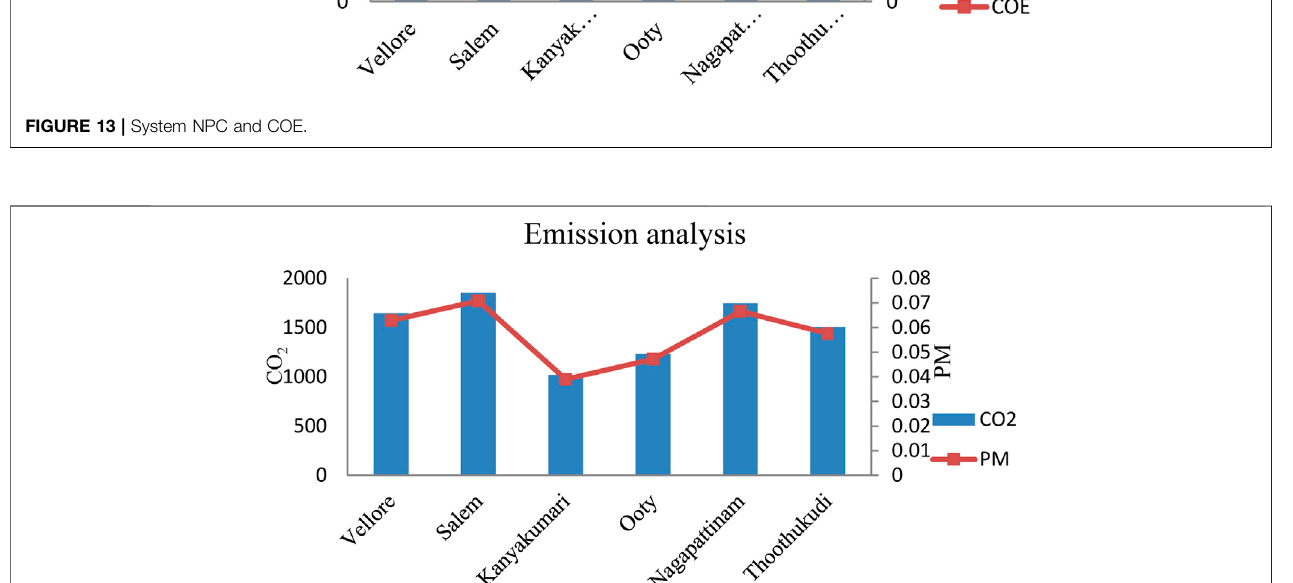
FIGURE 14 | System emission analysis.